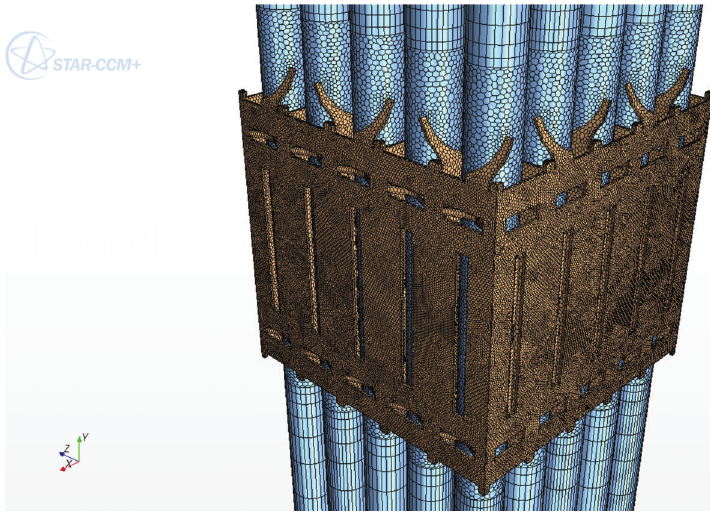
Figure 1: CFD grid of spacer with mixing vanes.